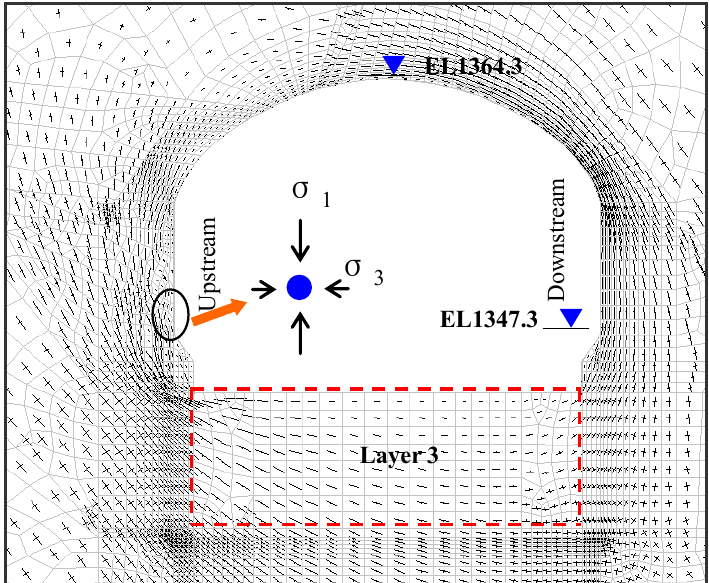
Figure 11. Stress vector diagram of surrounding rock after excavation of the second